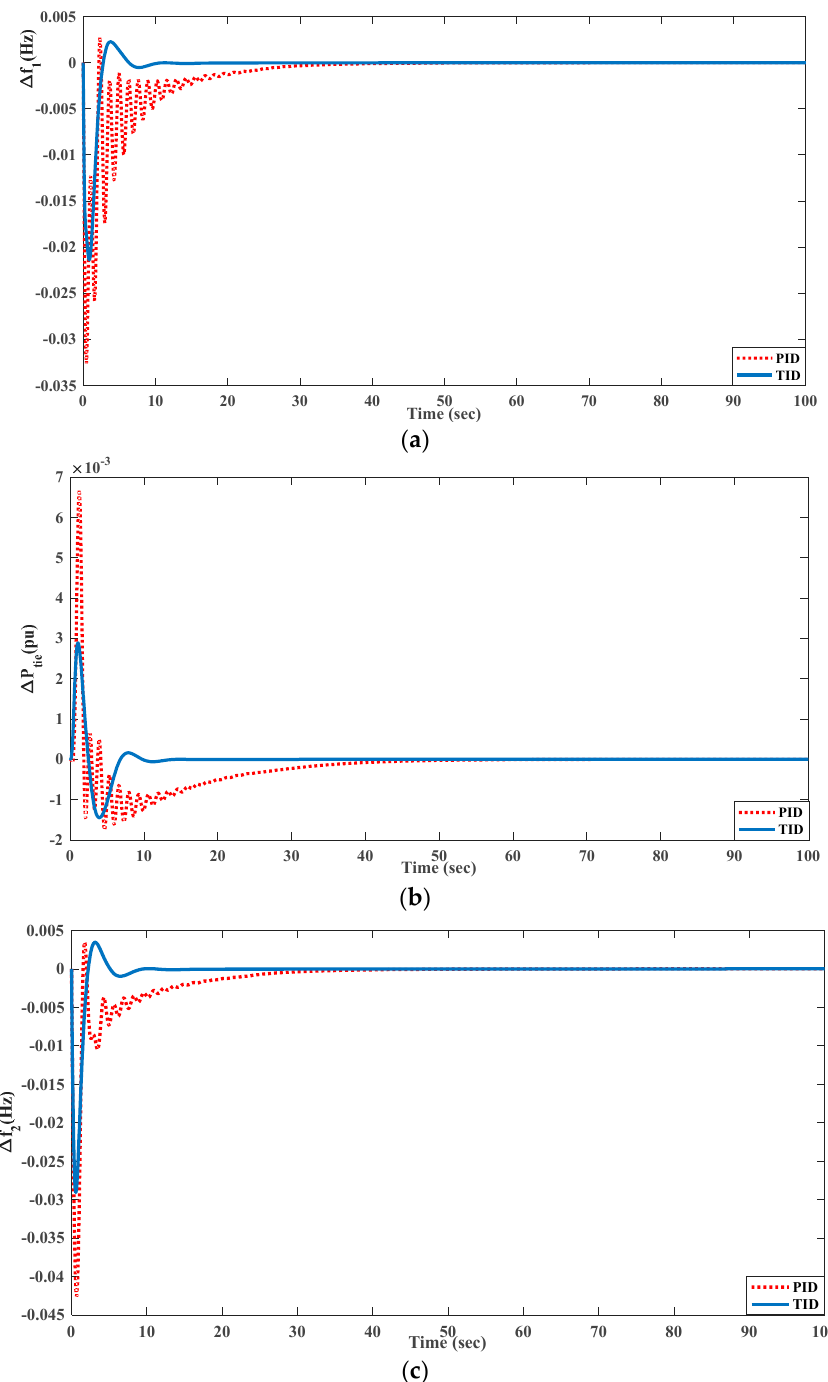
Figure 12. System dynamics of the PID and TID controllers with 2% SLP in both areas. ( a ) Δ f 1 ; ( b ) Δ P tie ; ( c ) Δ f 2 .